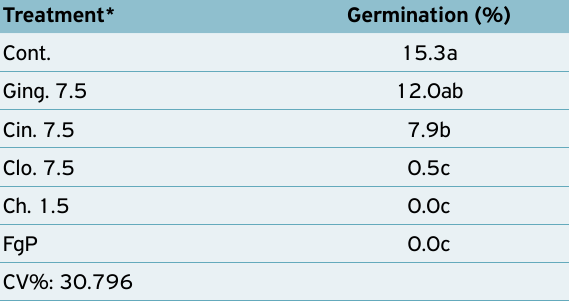
Table 2. Spore germination (%), in vitro , of C . gloeosporioides under different treatments: control (Cont.); 7.5% ginger (Ging 7.5); 7.5% cinnamon (Cin. 7.5); 7.5% clove (Clo. 7.5); 1.5% chitosan (Ch. 1.5), and the fungicide Prochloraz at 50 μ g.mL ‑1 (FgP). Dourados, Mato Grosso do Sul, UFGD, 2014.